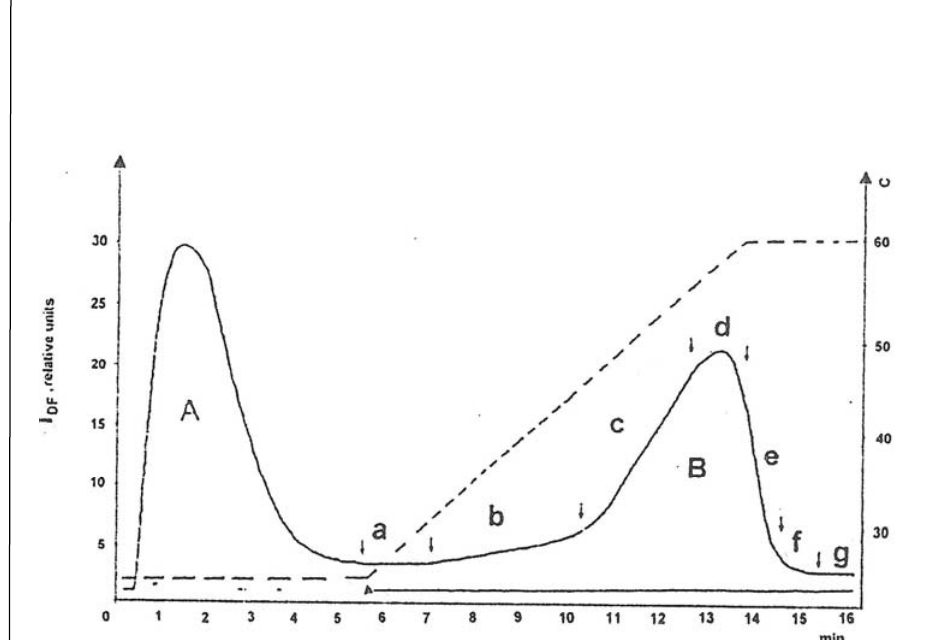
Figure 3 – Schematic presentation of the empirical procedure of typical changes of delayed chlorophyll fluorescence intensities (I DF ) on the intact above-ear leaf of the observed maize inbred lines with significant breeding properties (solid line) and changes of temperatures (dashed line): the curve A indicates induction processes of delayed chlorophyll fluorescence, while the curve B encompasses photosynthetic fluorescence thermal processes of delayed chlorophyll fluorescence. Typical temporal segments (a, b, c, d, e, f, and g) on the thermal curve B correspond to the dynamics of I DF changes at the time of delayed chlorophyll fluorescence formation. Conformational and functional changes in the thylakoid membrane of the observed maize inbred lines with erect top leaves occur at the interception points of typical temporal